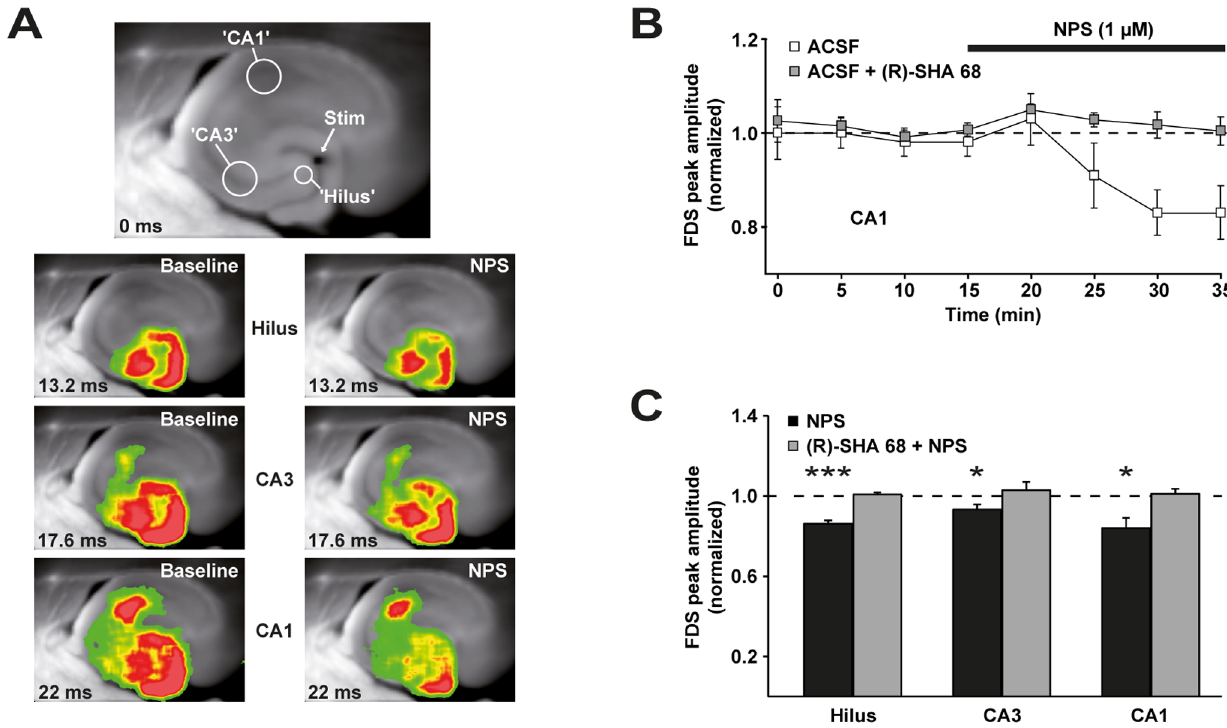
Figure 4. NPS rapidly weakens evoked neuronal activity flow from the DG to area CA1 in hippocampal slices prepared from C57BL/ 6N mice. A, (Upper panel) Illustration of the position of the stimulation electrode (Stim) and the three ROIs used for the calculation of neuronal population activity within the dentate hilus, the CA3 subfield, and area CA1. (Lower panels) Representative filmstrips depicting the propagation of VSDI signals from the DG to the CA1 region before (‘Baseline’) and after bath application of 1 m M NPS (‘NPS’). Warmer colors represent stronger neuronal activity. Time specifications are given relative to the electrical stimulation pulse. B, Time course of the experiments depicted for the CA1 output subfield of the VH. NPS (1 m M) decreased FDS peak amplitudes (84 6 5% of baseline, n=7 slices from 6 mice). This effect was completely abolished by pretreatment (15 min) of slices with the specific NPSR antagonist (R)-SHA 68 (10 m M) (101 6 3% of baseline, n=5 slices from 4 mice). Data were normalized to the mean FDS peak amplitude of the last two acquisitions during baseline recording. C, Quantification of NPS effects on FDS peak amplitudes in the dentate hilus, the CA3 region, and area CA1. NPS decreased FDS peak amplitudes in the dentate hilus to 86 6 2% (p , 0.001, t=8.357, df=6), in CA3 to 93 6 3% (p=0.037, t=2.664, df=6), and in CA1 to 84 6 5% (p=0.019, t=3.165, df=6) of baseline values. These effects were completely abolished by the NPSR antagonist (R)-SHA 68 (10 m M). Statistical evaluation was performed by comparing the mean FDS peak amplitudes of the last two acquisitions during baseline recording with the mean FDS peak amplitudes of the last two acquisitions during application of